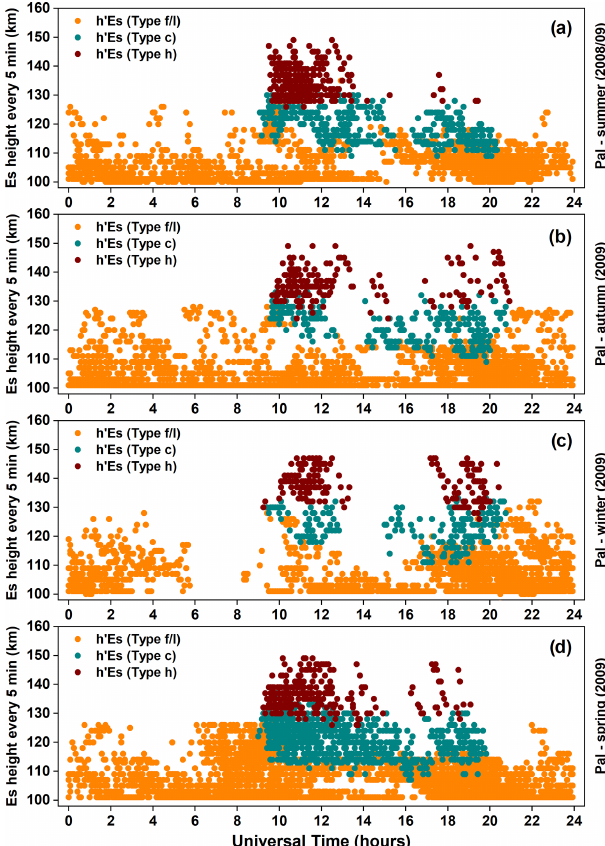
Figure 2. Virtual height distribution of the E s layer types as a func- tion of time (in UT) over Palmas during summer (a) , autumn (b) , winter (c) , and spring (d)